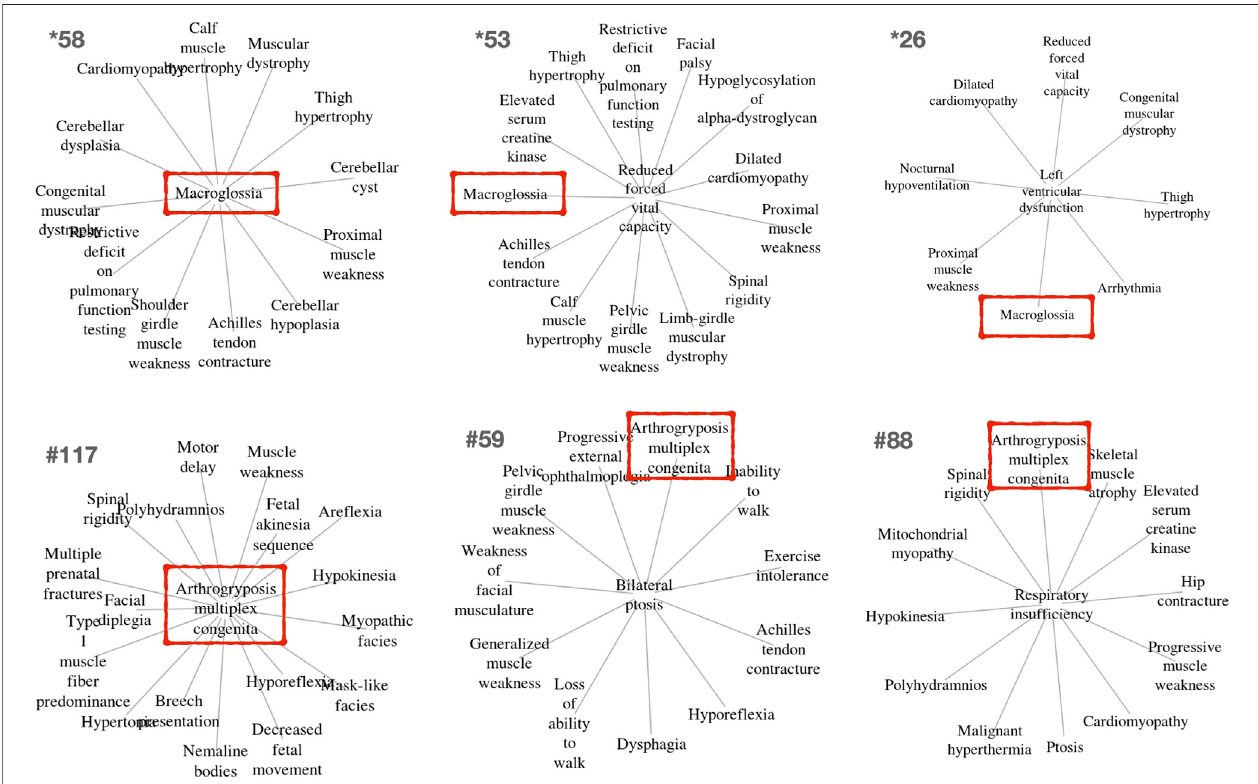
FIGURE 3 | Example clusters including the unexpected but key macroglossia (HP:0000158) and arthrogryposis multiplex congenita (HP:0002804) phenotypes identi fi ed in OMIM and Orphanet, respectively. These phenotypes are marked in red boxes. The relevance of these phenotypes for differential diagnosis is further described in the